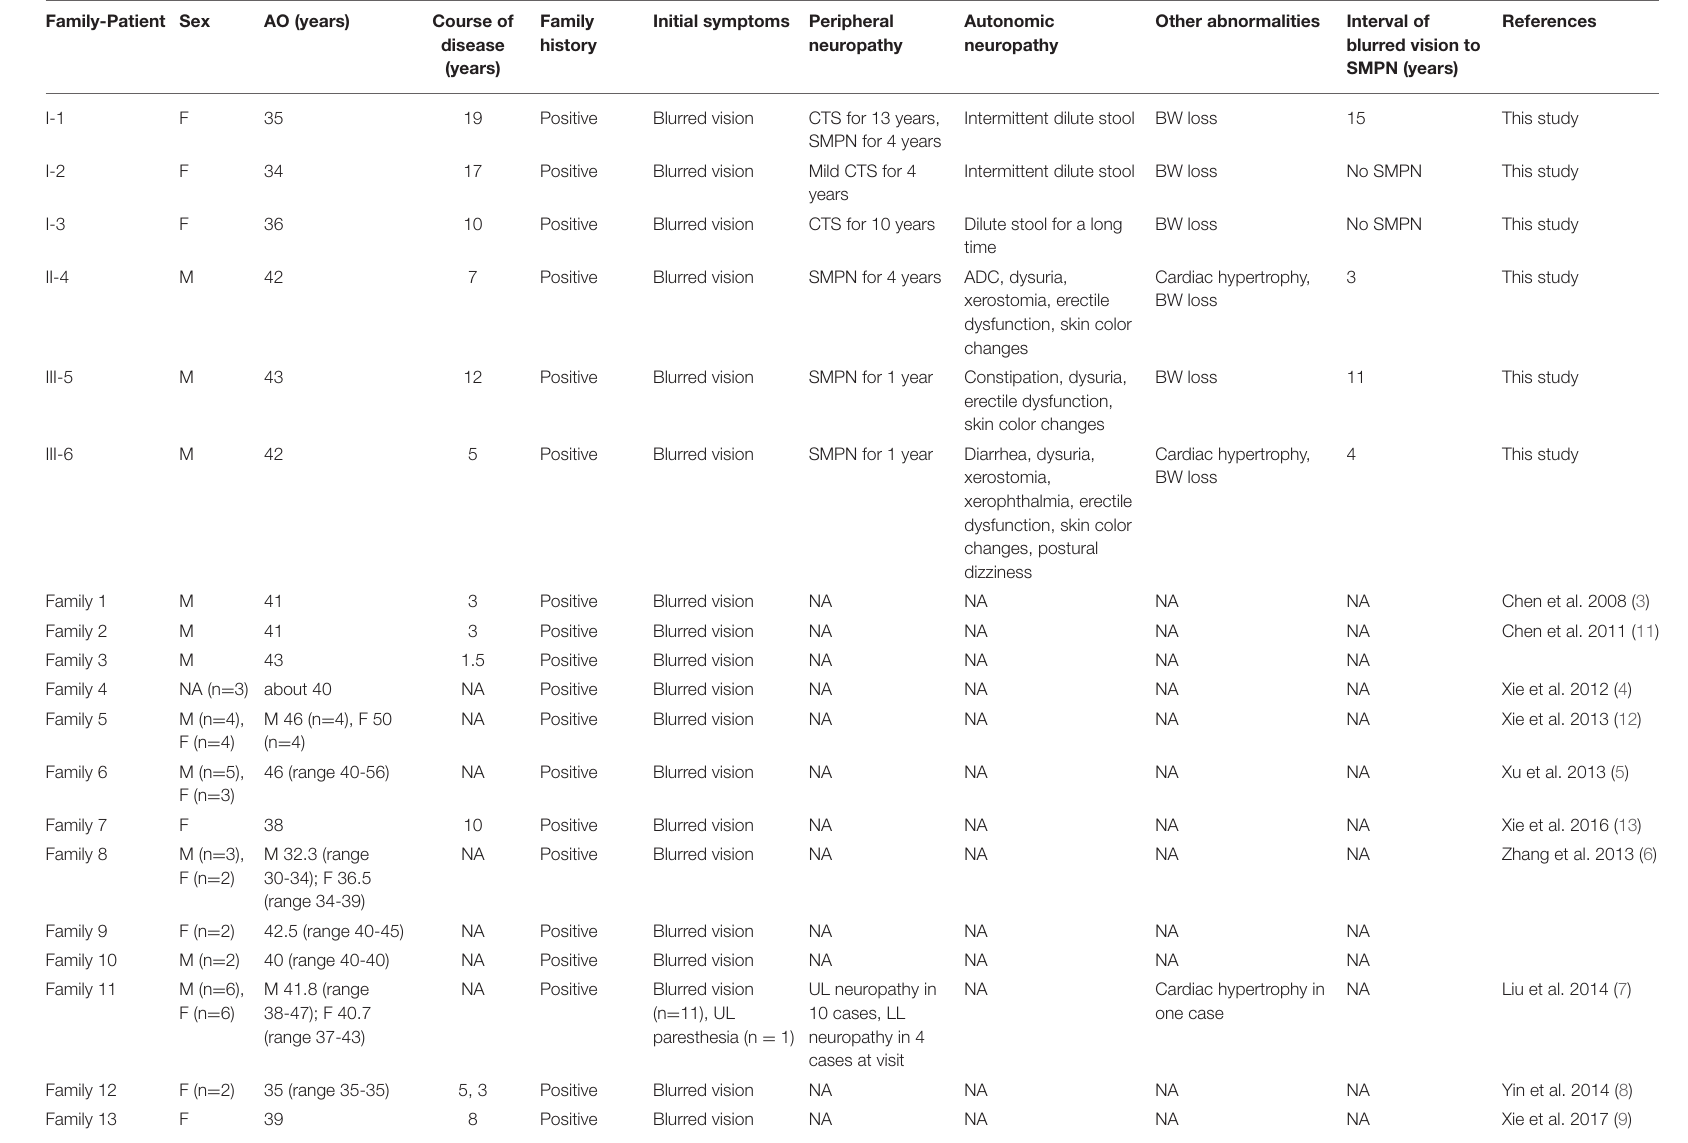
TABLE 1 | Characteristics of patients with symptomatic Gly83Arg-related ATTR in this study and reviews. Family-Patient